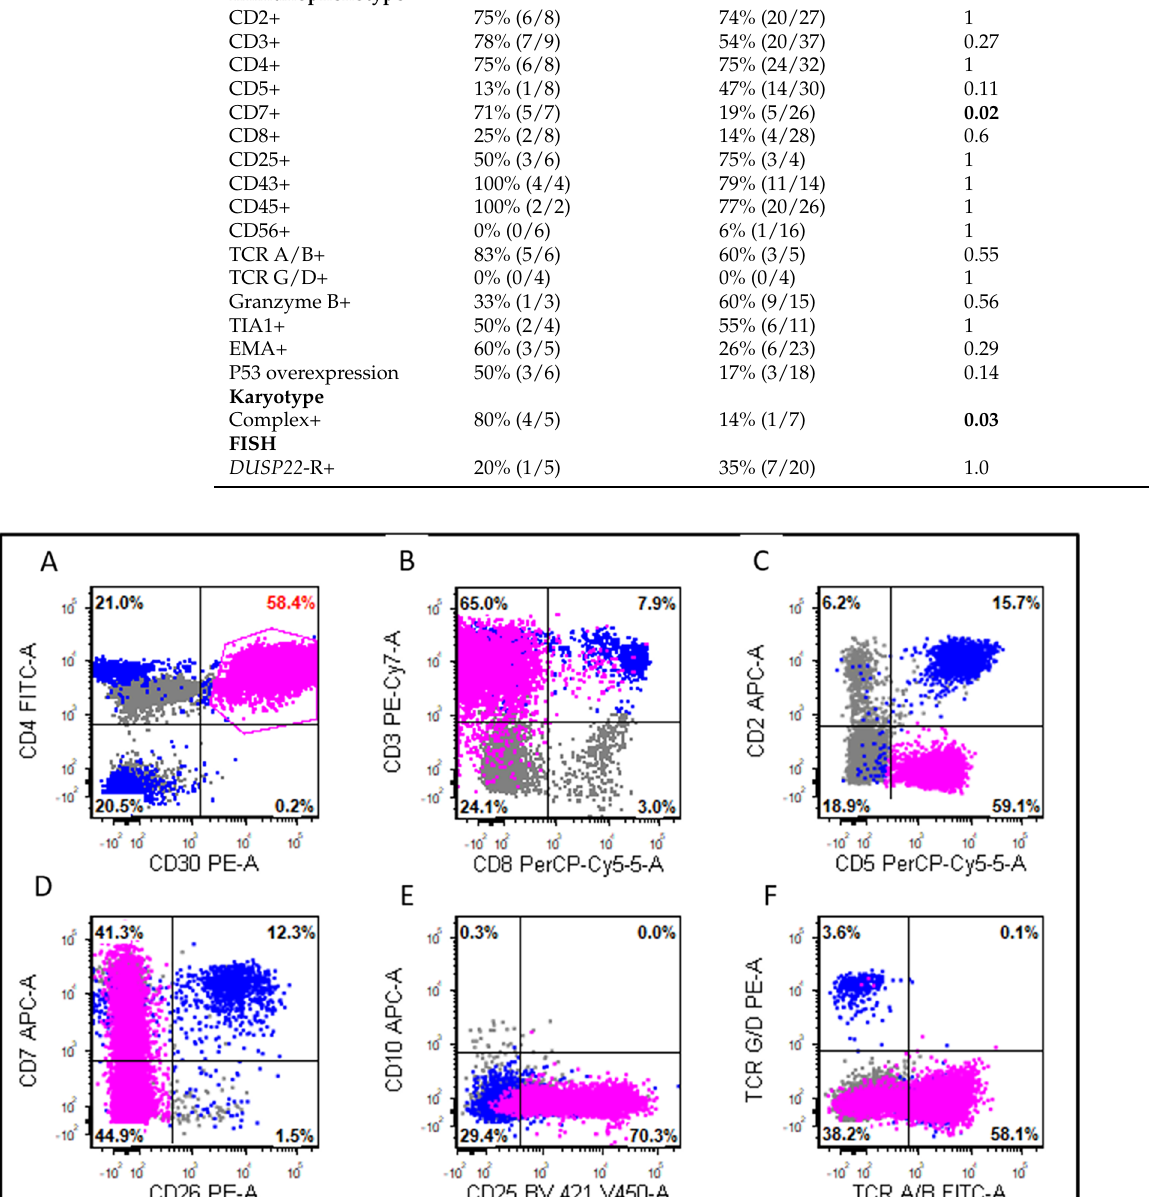
Figure 2. Flow cytometric immunophenotypic analysis of the case shown in Figure 1. The lymphoma cells (pink dots) were positive for CD30 ( A ), CD4 ( A ), CD3 ( B ), CD5 (decreased, C ), CD7 (partial, D ), CD25 ( E ), T-cell receptor (TCR) alpha/beta (partial, F ), and were negative for CD8 ( B ), CD2 ( C ), CD26 ( D ), CD10 ( E ), and TCR gamma/delta ( F ). The blue dots represent background reactive T-cells.